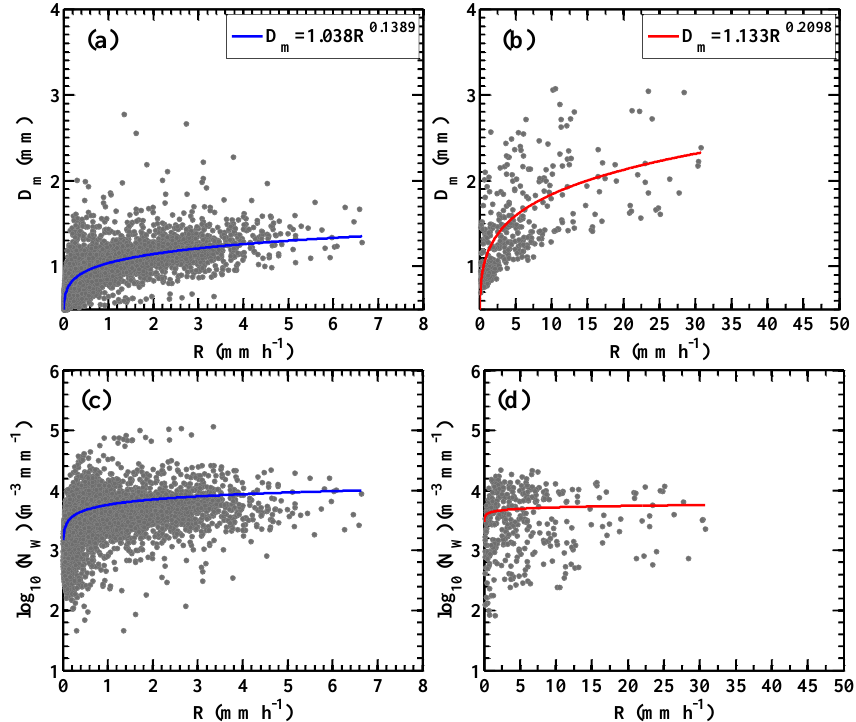
Figure 10. Scatterplots of the mass-weight mean diameter D m and generalized intercept parameter N w versus the rain rate R. ( a ) D m versus R for the stratiform rain, ( b ) D m versus R for the convective rain, ( c ) N w versus R for the stratiform rain, ( d ) N w versus R for the convective rain. The blue and red lines are the results for the stratiform and convective rains fitted using the linear least squares method.